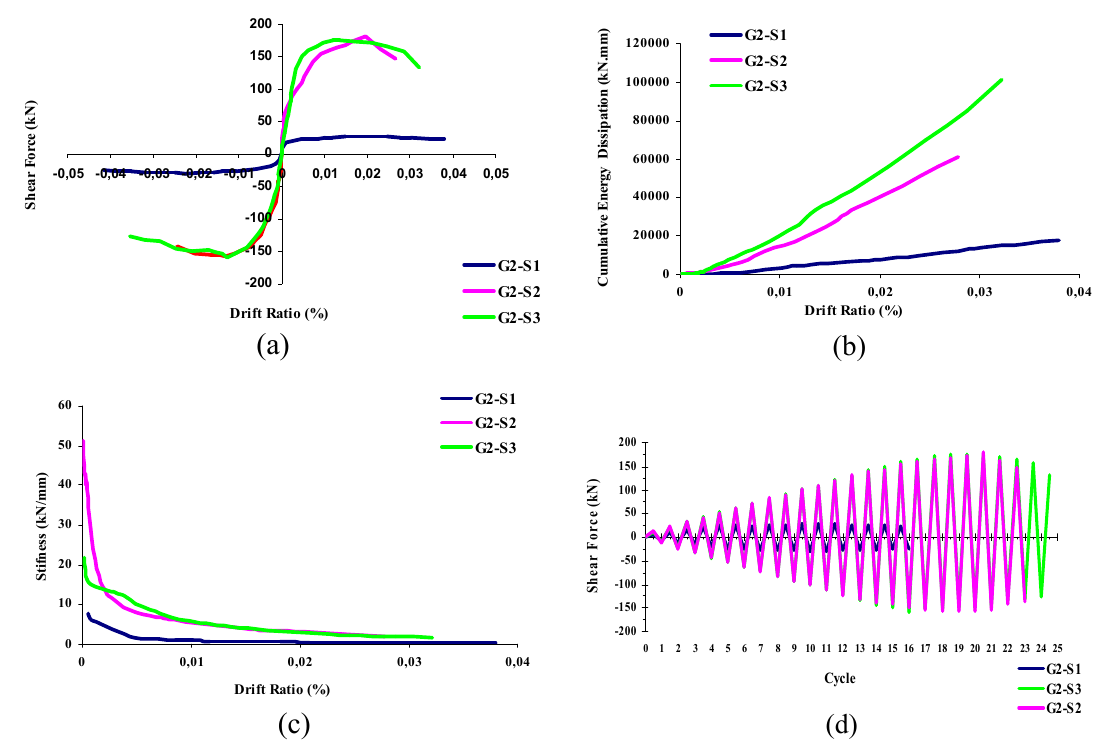
-S ) (Ozturk, 2010) 2 3